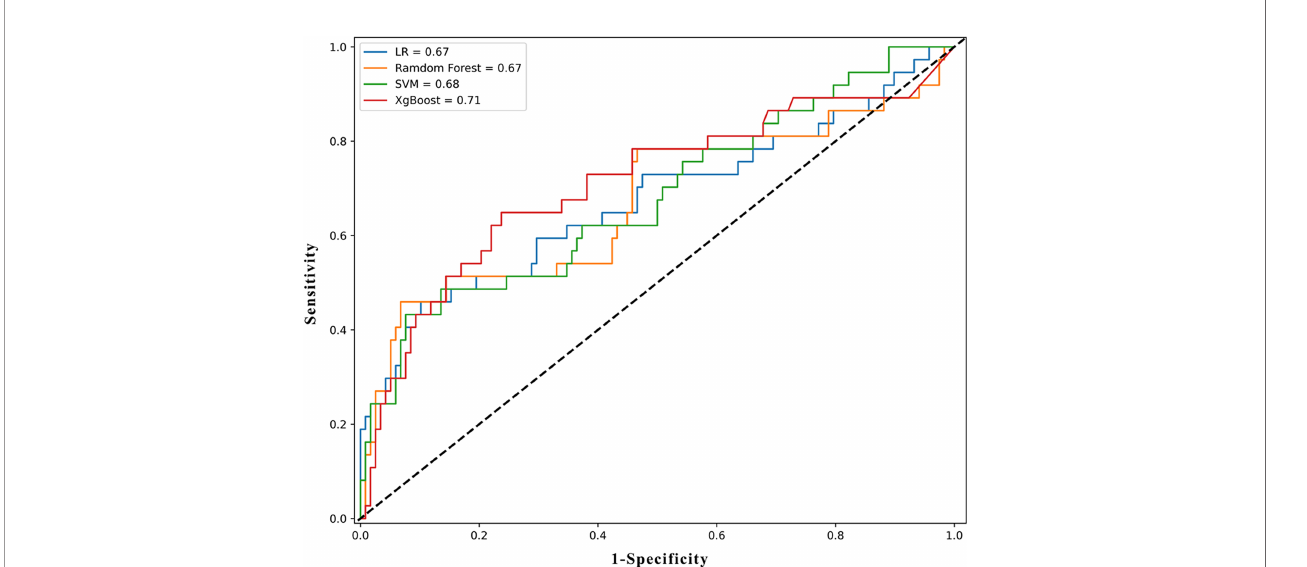
FIGURE 4 | The ROC results of machine learning models. ROC, receiver operating characteristic curve; LR, logistic regression; XGboost, eXtreme Gradient Boosting; SVM, support vector